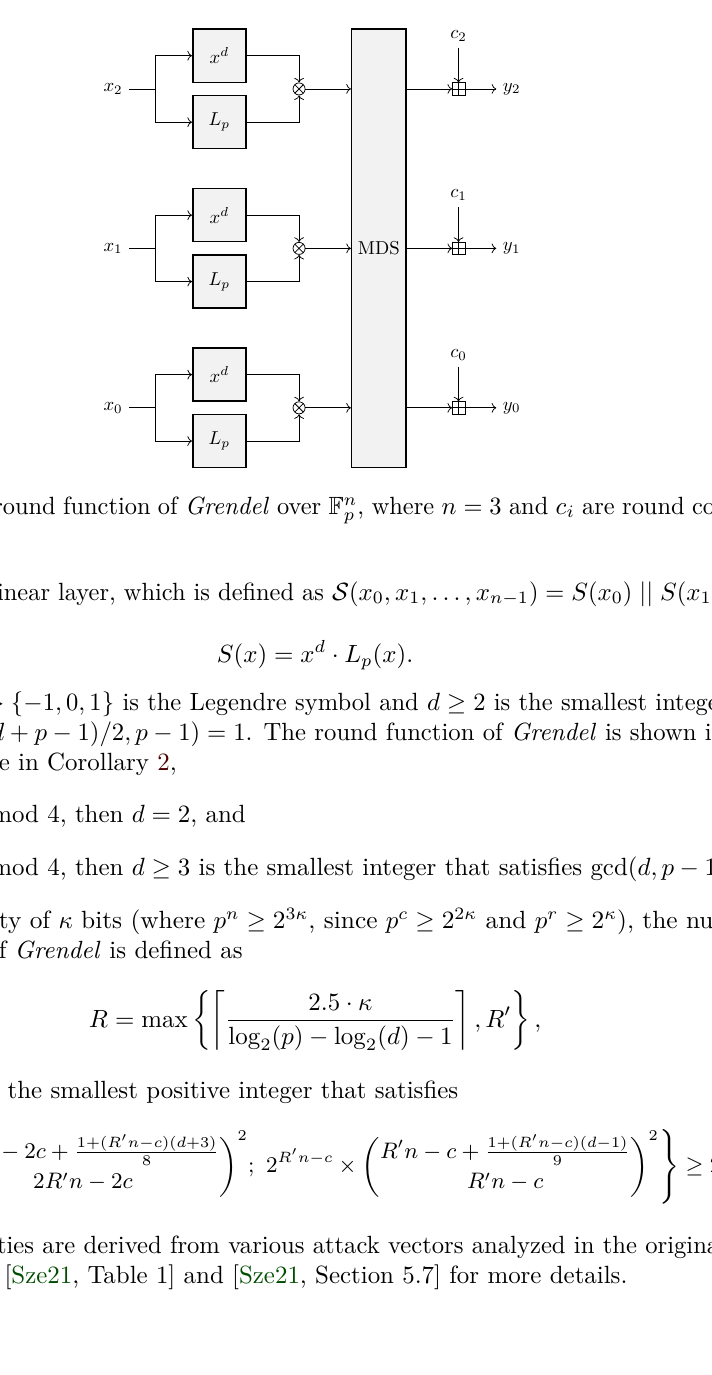
Figure 1: A sponge hash function with a two-element output, where ⊕ denotes the element-wise addition of two vectors in F r .